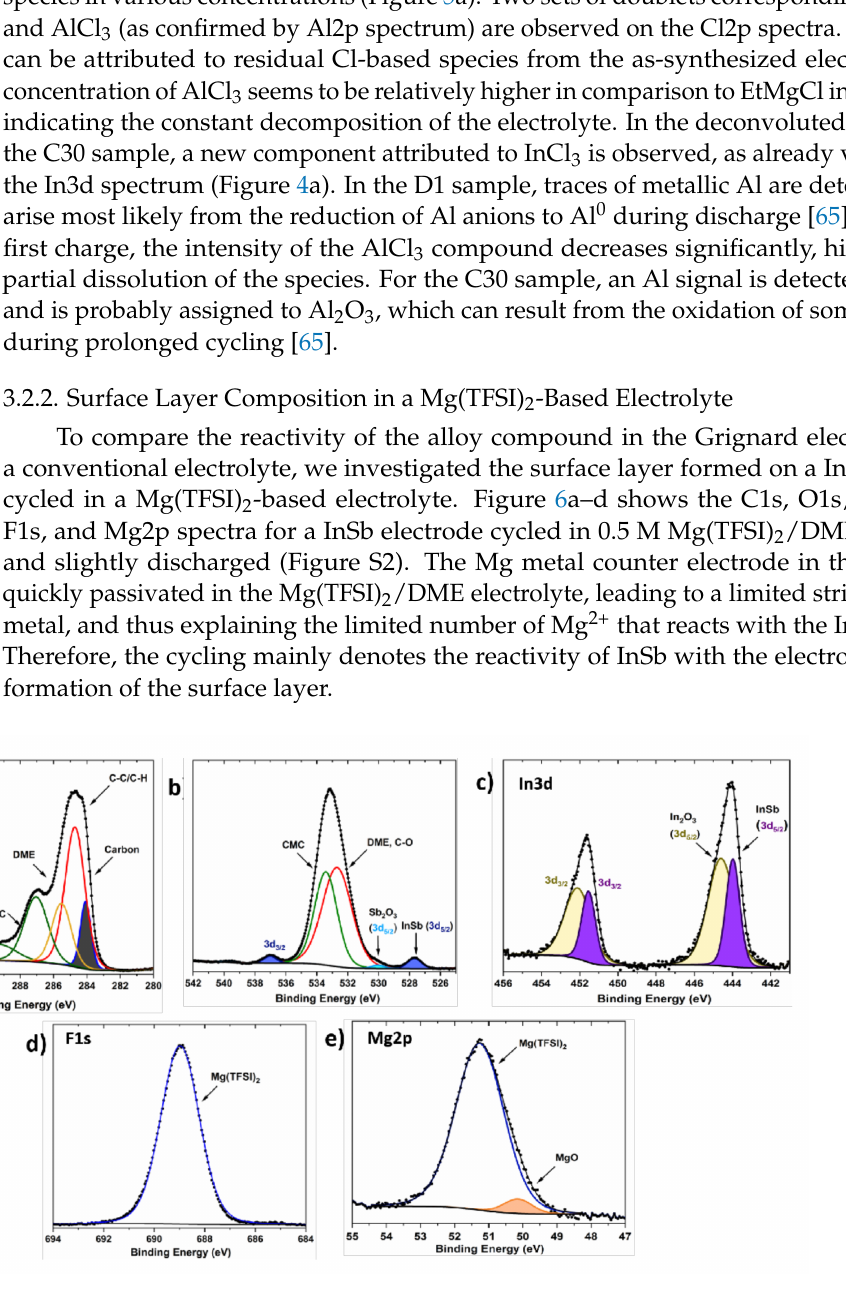
Figure 6. ( a ) C1s, ( b ) O1s/Sb3d, ( c ) In3d, ( d ) F1s, and ( e ) Mg2p core peaks spectra of slightly demagnesiated InSb in 0.5 M Mg(TFSI) 2 /DME